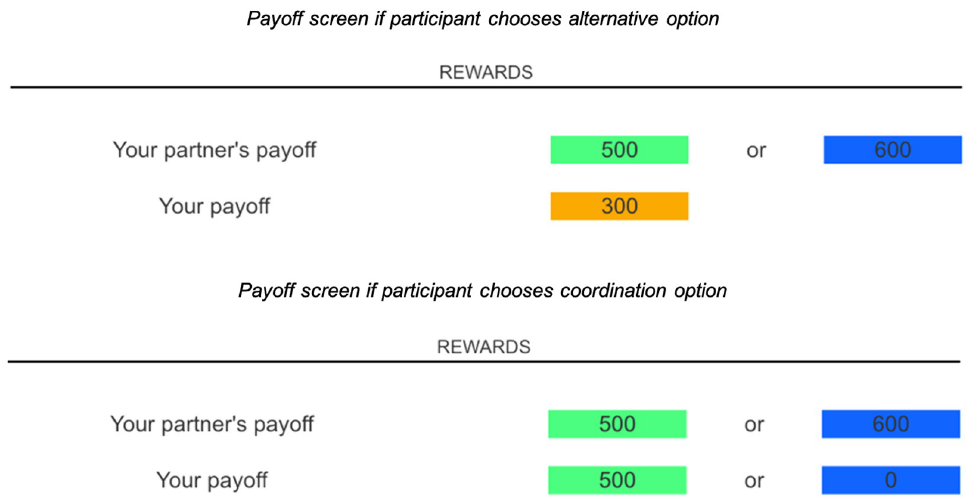
Fig 6. Experiment 2 payoff structure. If the participant chose the alternative option (orange), then payoffs were determined as in the top half of the figure above: the participant received the guaranteed amount (300), and the partner received the amount corresponding to the option s/he had chosen: 600 if s/he had chosen the alternative option (blue) or 500 if she had chosen the coordination option (green). Conversely, if the participant chose the coordination option, the payoffs were determined as in the bottom half of the figure above: If the partner had chosen the coordination option (green), then each player received the corresponding amount (500); if the partner had chosen the then both chosen the alternative option (blue), the partner received the corresponding amount and the participant received 0. Participants should thus only choose the coordination option if they believed their partner had likewise done so. While payoffs for the coordination option and for participants’ alternative options were fixed, we varied the amount associated with the partner’s alternative option unpredictably across trials. Payoffs were displayed for a set amount of time before participants proceeded to the next